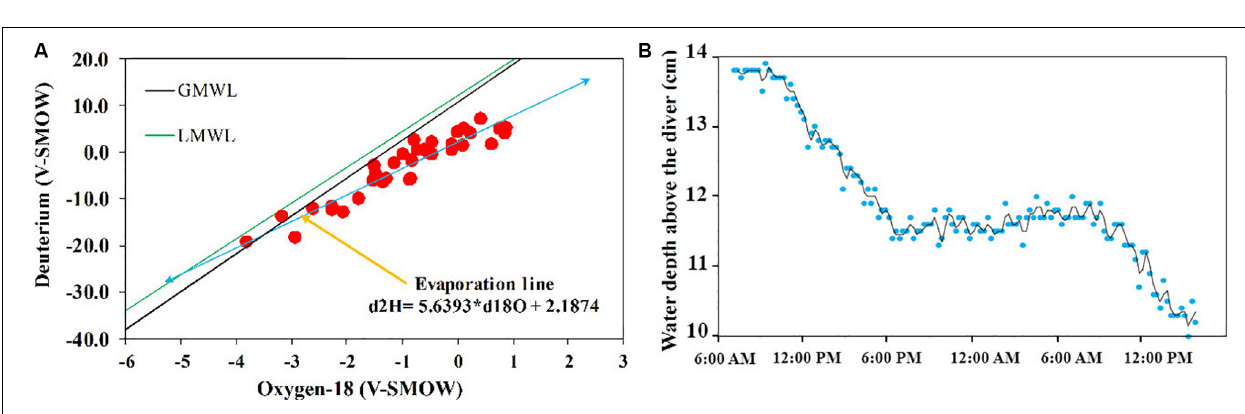
FIGURE 6 | (A) Isotopic composition for samples from the sand deposits; (B) Diurnal fluctuations in water level obtained from water level measurements in the